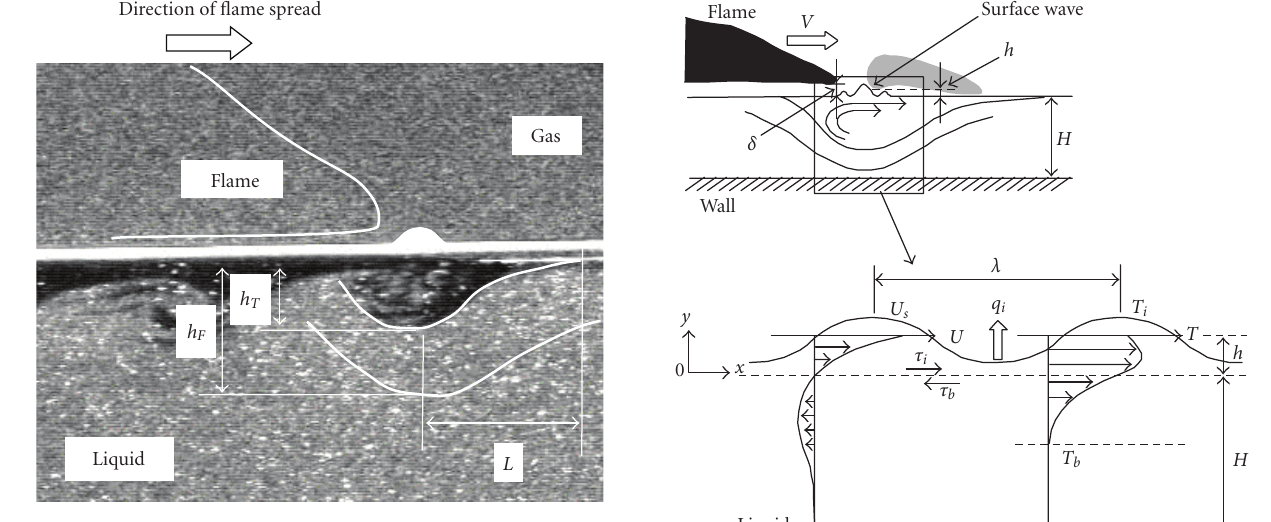
Figure 2: A shadowgraph and a particle laser-sheet image defining thermal characteristic length, L , and thermal and flow depth, h T and h F , of subsurface layer circulation (fuel is n-butanol, H = 50 mm and the initial fuel temperature = 23 . 2 ◦ C). Figure 3: Subsurface layer flow model and